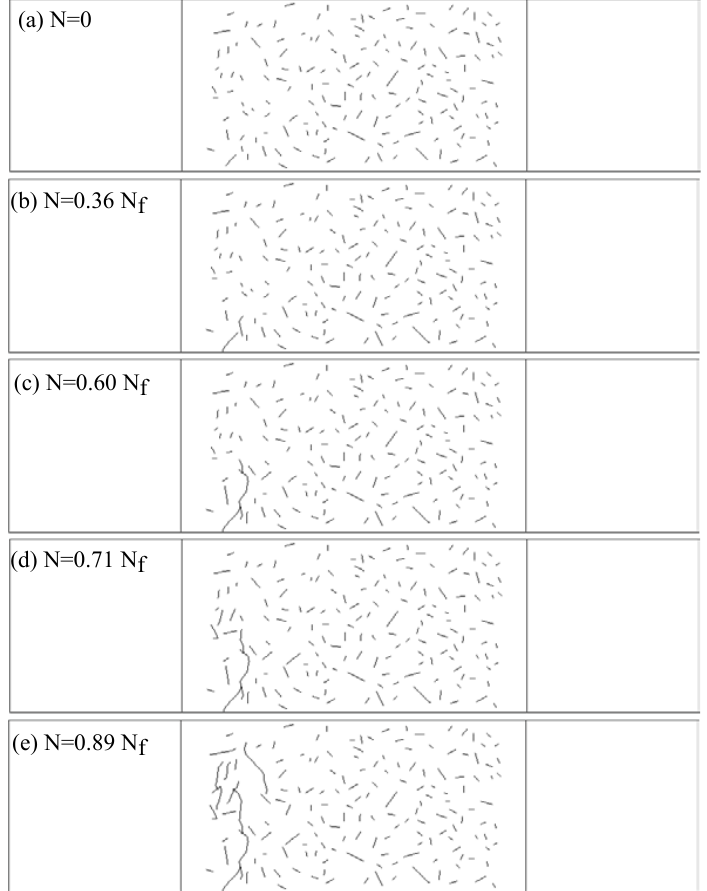
Figure 9. Evolution of crack